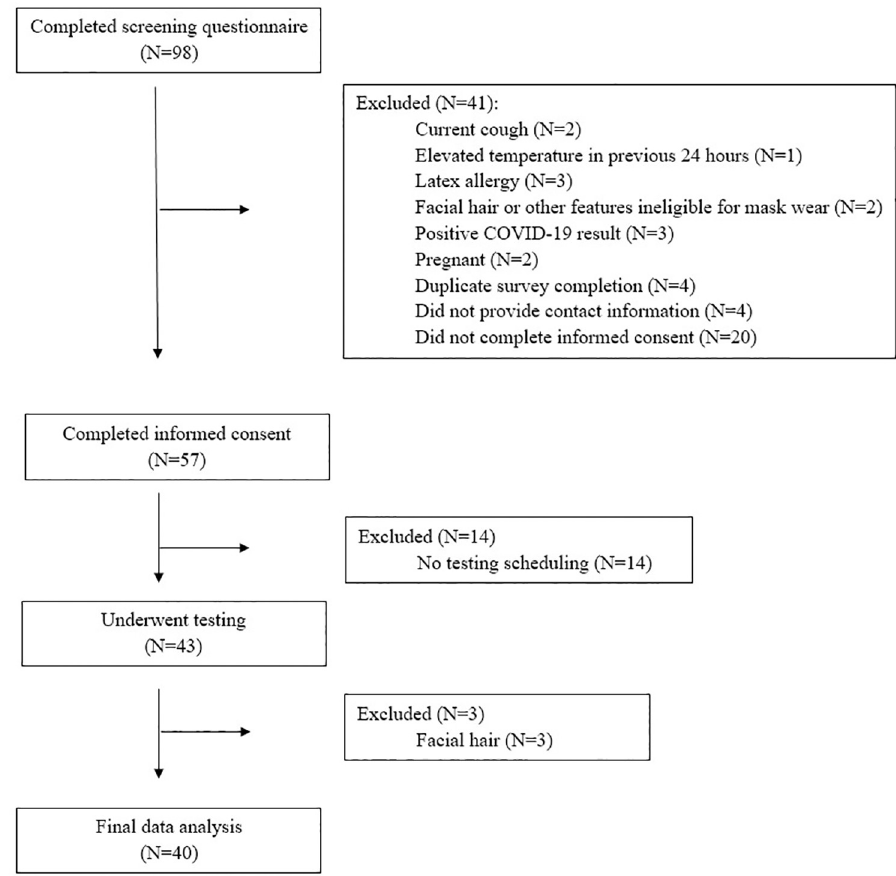
Fig 2. Study flow diagram from screening to data